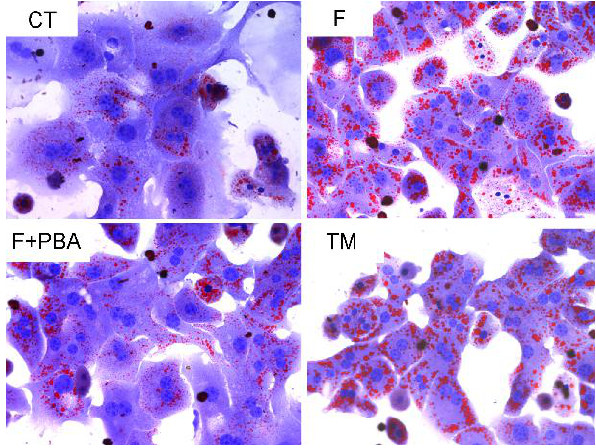
Figure 3. Effect of ER stress response on TG accumulation in primary mouse hepatocytes by treatment with ER stress inhibitor PBA or ER stress inducer TM. Oil Red O staining. Original magnification: ×400; CT: control; F: fructose; F + PBA: fructose plus PBA pretreatment; TM: tunicamycin.